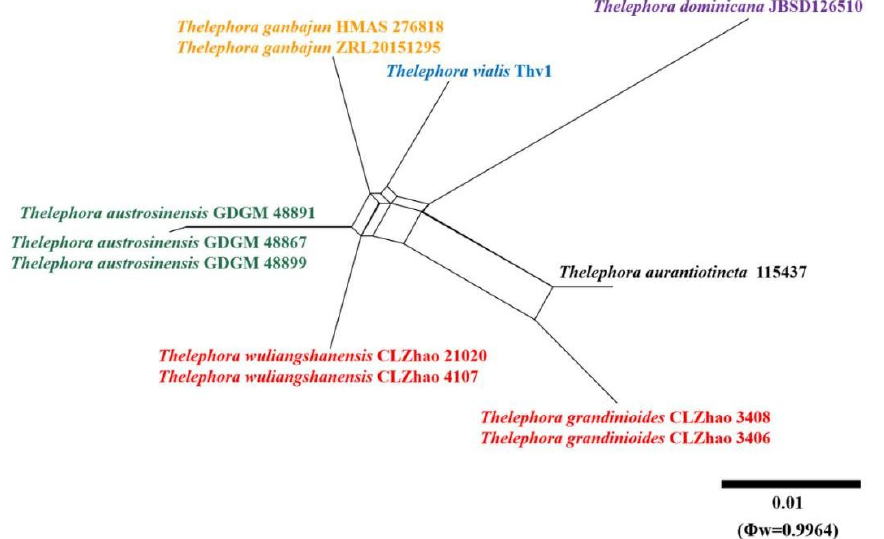
Figure 6. Split graphs showing the results of PHI test for the nrLSU data of Thelephora grandinioides and T. wuliangshanensis and closely related taxa using LogDet transformation and splits decomposition. PHI test results Φ w ≤ 0.05 indicate that there is significant recombination within the dataset. New taxa are in red while, closly related species to new species are in other colors.